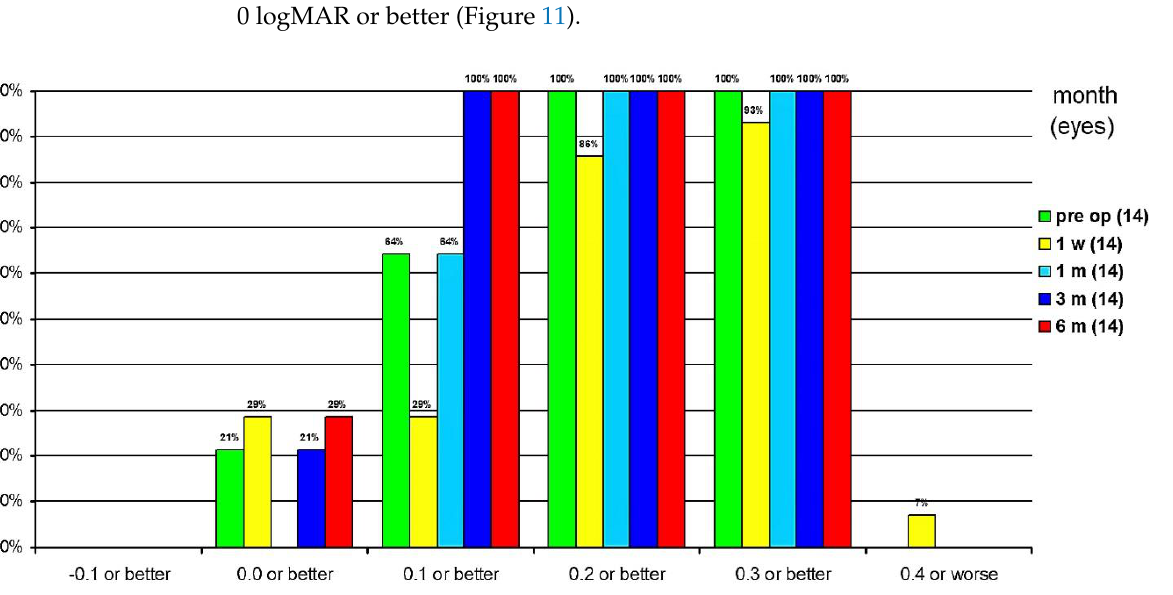
Figure 12. Cumulative uncorrected distance visual acuity.